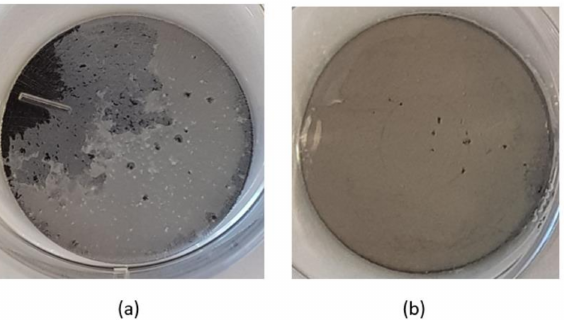
Figure 1. Bacterial biofilm formation on different titanium discs ( a ) S. mutans biofilm on Ti grade 23, ( b ) S. aureus biofilm on Ti grade 5